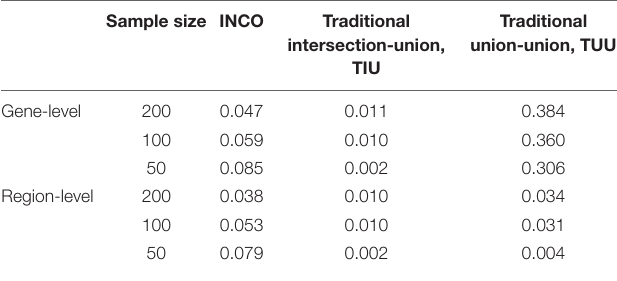
TABLE 4 | The false positive rates calculated at the gene-level and at the region-level under the simulation setting A1 of null effects. Sample size INCO Traditional